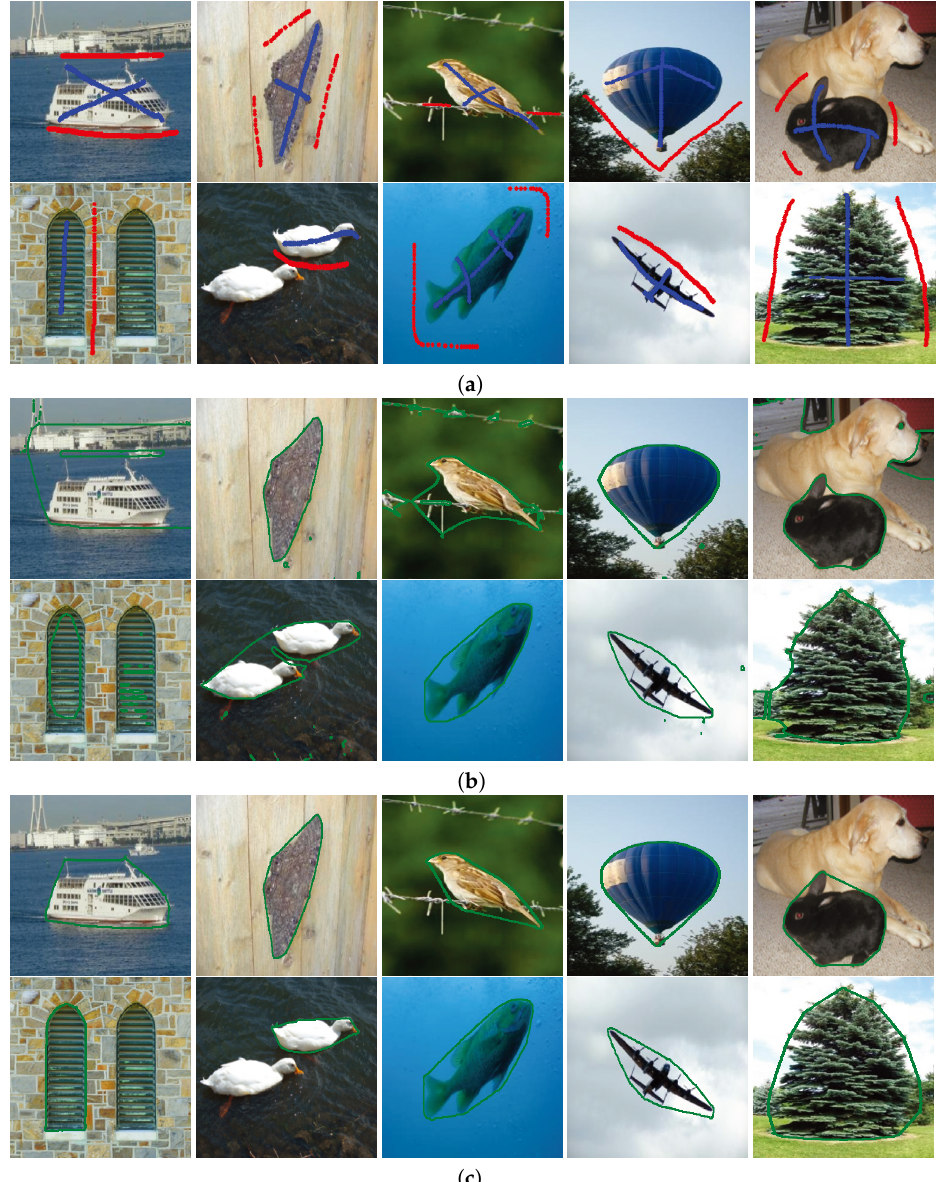
Figure 3. Different convex shape image segmentation results for images in WSED, where ( a ) shows ten original images on which blue and red markers were used to differentiate the foreground region and the background region, respectively, and ( b , c ) are corresponding image segmentation results of ( a ) obtained from the BLF–TV–CS method and our proposed PPA–CS method,